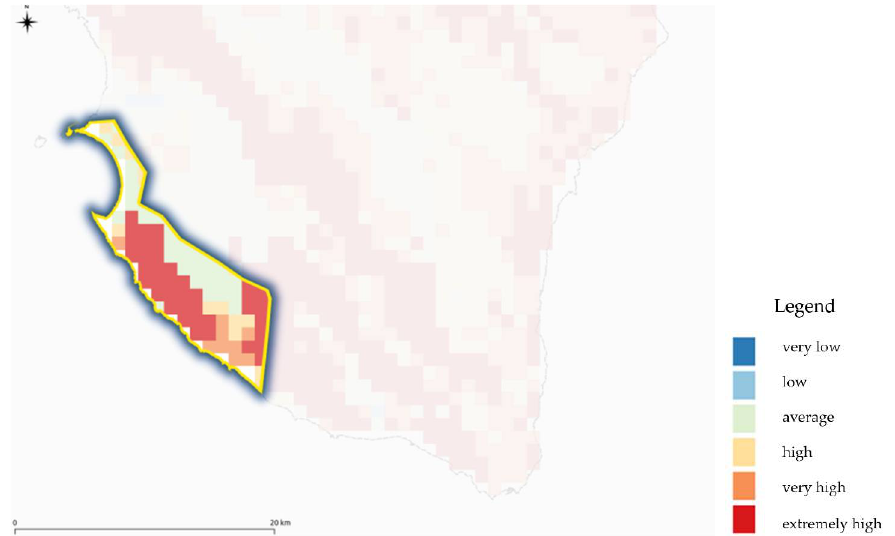
Figure 8 . Example of continuity-discontinuity assessment of the vulnerability value in the selected areas obtained by DRASTIC model application .